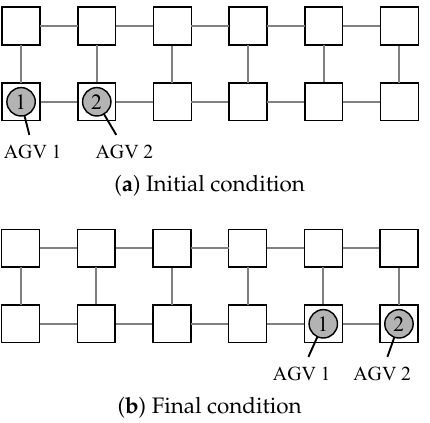
Figure 15. Initial and final condition for a sample route planning